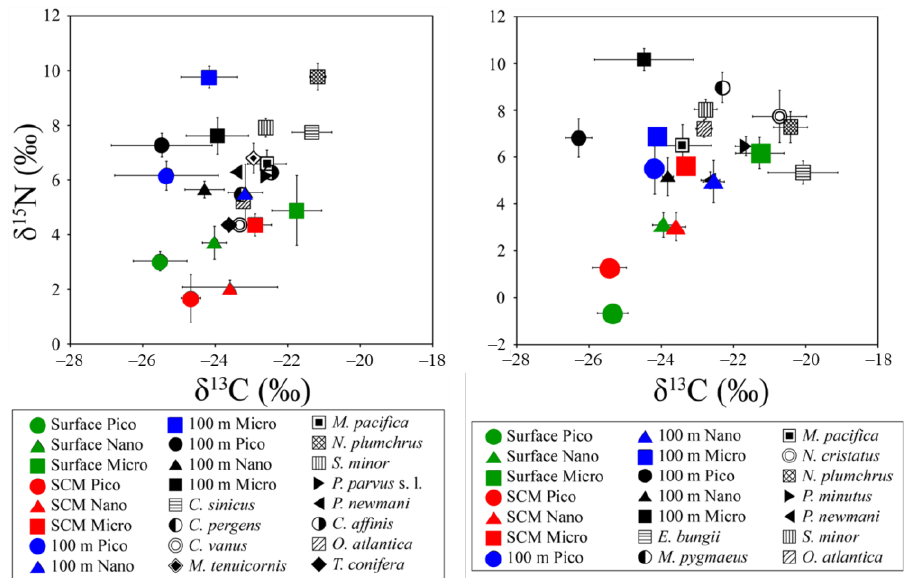
Figure 4. Mean (±SD) δ 13 C versus δ 15 N values of pico- to micro-particulate organic matter (POM) within ~200 m depth layers and for copepods in the south ( A ) and north ( B ) regions of the subpolar front.